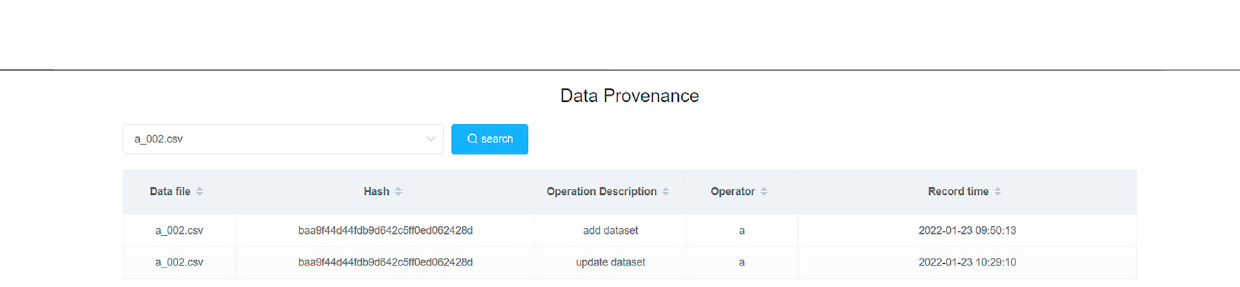
Frontiers in Genetics |